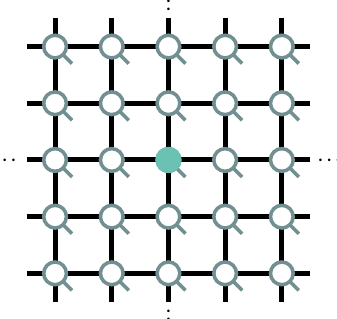
Figure 1: Schematic picture of an excitation tensor in the center of an infinite